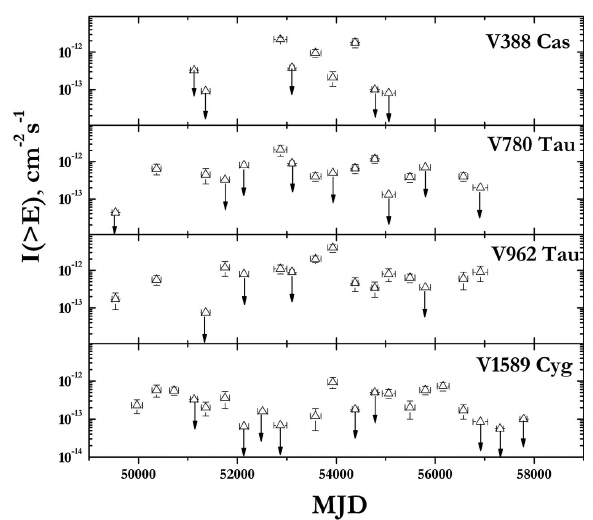
Figure 4. Light curves of V388 Cas, V780 Tau, V962 Tau, V1589 Cyg at TeV energies from long-term SHALON observations. 95% are dwarf stars of G-M spectral classes [14].